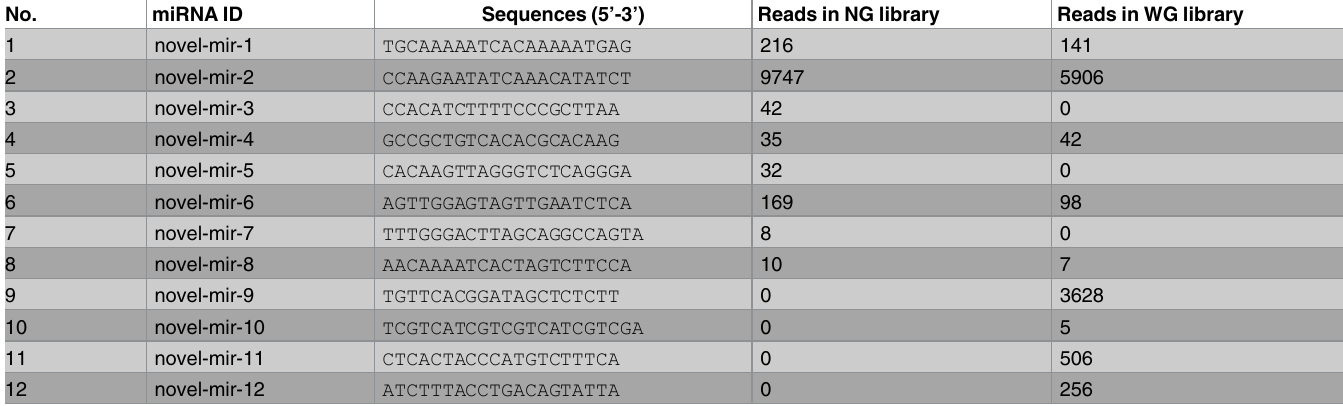
Table 2. Novel miRNAs identified in NG and WG